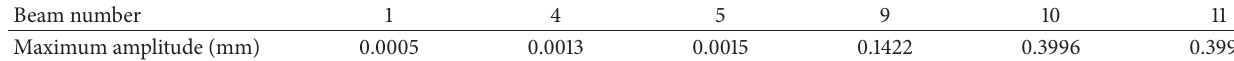
Table 3: 𝑧 -direction maximum amplitude of beams in 𝑁 𝑠 .